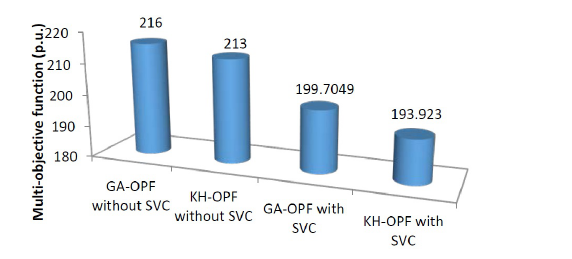
Figure 6: Comparison of objective function values with contingency for different